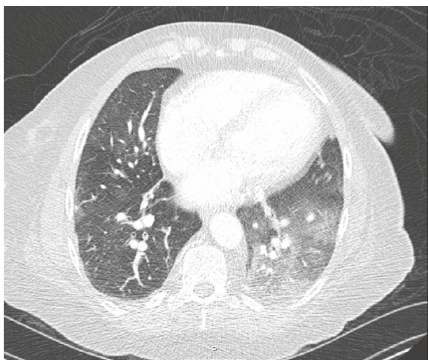
Figure 1: CT chest showing ground glass opacities predominantly on the left side (case 1).